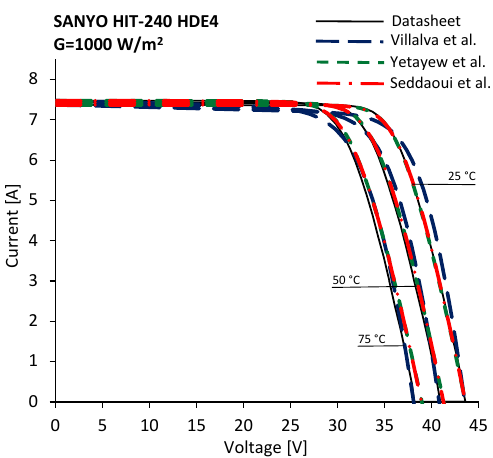
Figure 14. Comparison between the issued I-V characteristics of Sanyo HIT-240 HDE4 at G = 1000 W/m 2 and the characteristics calculated by means of the Villalva et al ., the Yetayew et al . and the Seddaoui et al . models.